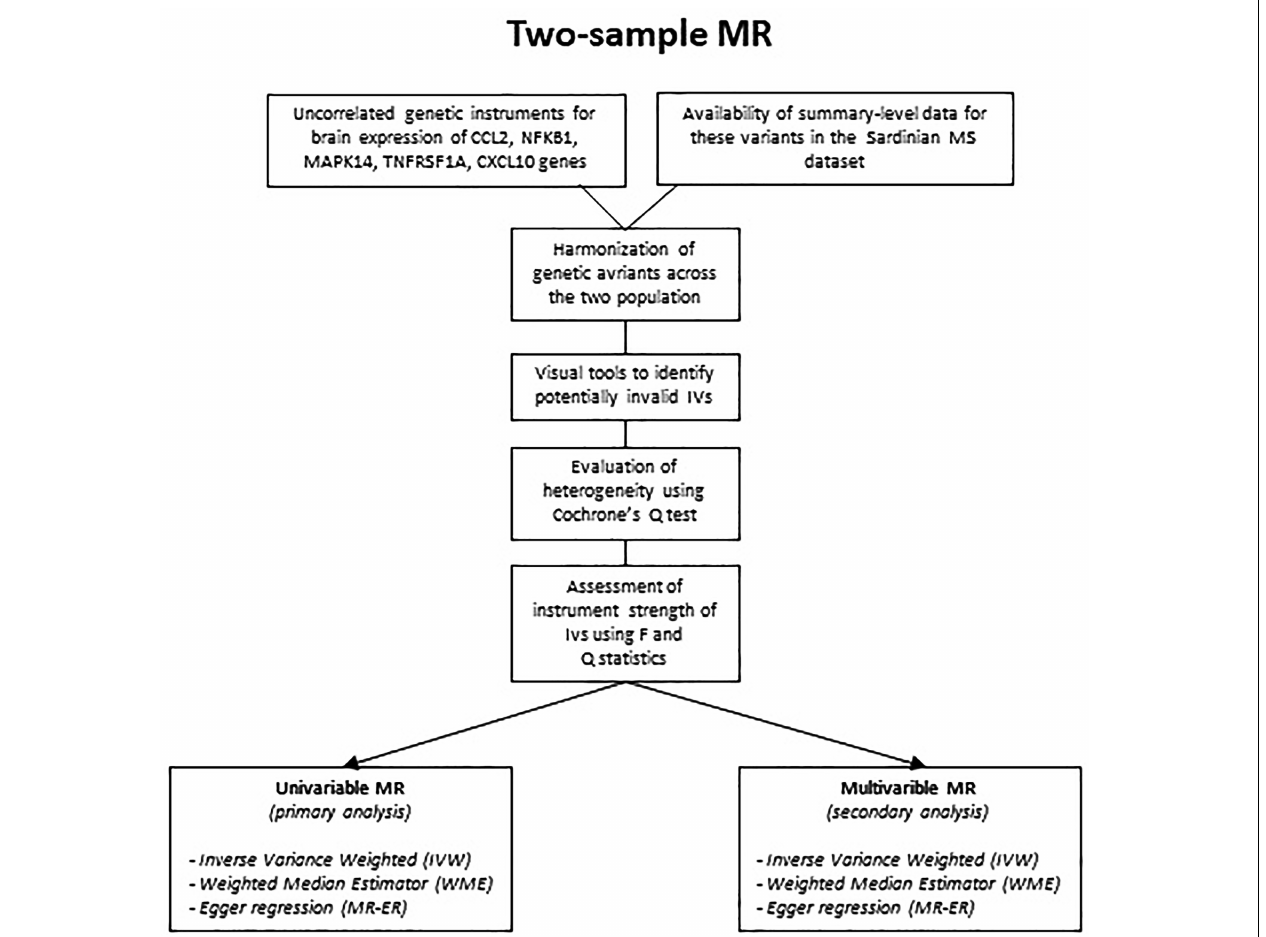
FIGURE 1 | Flowchart of the